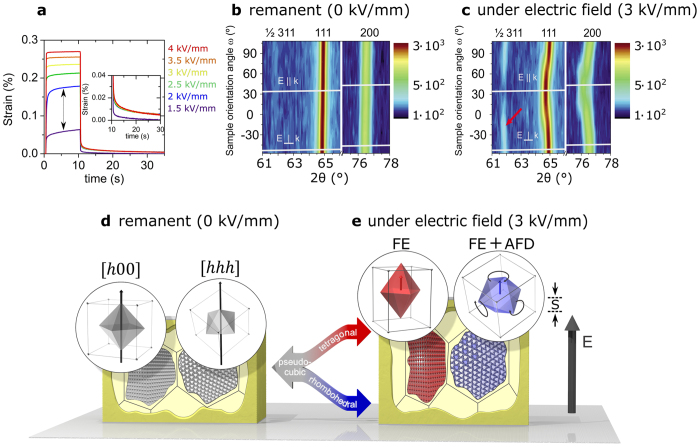
Macroscopic strain mechanisms.(a) Strain as a function of time for pulses of 10 s duration and electric fields ranging between 1.5 kV/mm and 4 kV/mm. Inset of (a) displays the strain decay after electric field removal. (b) remanent state at 0 kV/mm and (c) applied electric field state at 3 kV/mm contour plots of in situ neutron diffraction patterns for sample orientations in the ω range between −57° and 108°. The presented 2θ angular range of interest corresponds to the ½ 311, 111, and 200 reflections. The white lines superimposed indicate the patterns at ω = θ and ω = θ −90° which fulfil the condition of k∥E and k⊥E, respectively. The red arrow indicates the maximum intensity of the ½ 311 reflection. (d,e) visualize the two ideal cases of grains with 〈h00〉 and 〈hhh〉 oriented along the electric field. The strain of the material under electric field is given by S. Pseudocubic grains in the virgin state (grey) transform to either tetragonal (red) or rhombohedral (blue) symmetry due to FE or AFD instabilities.